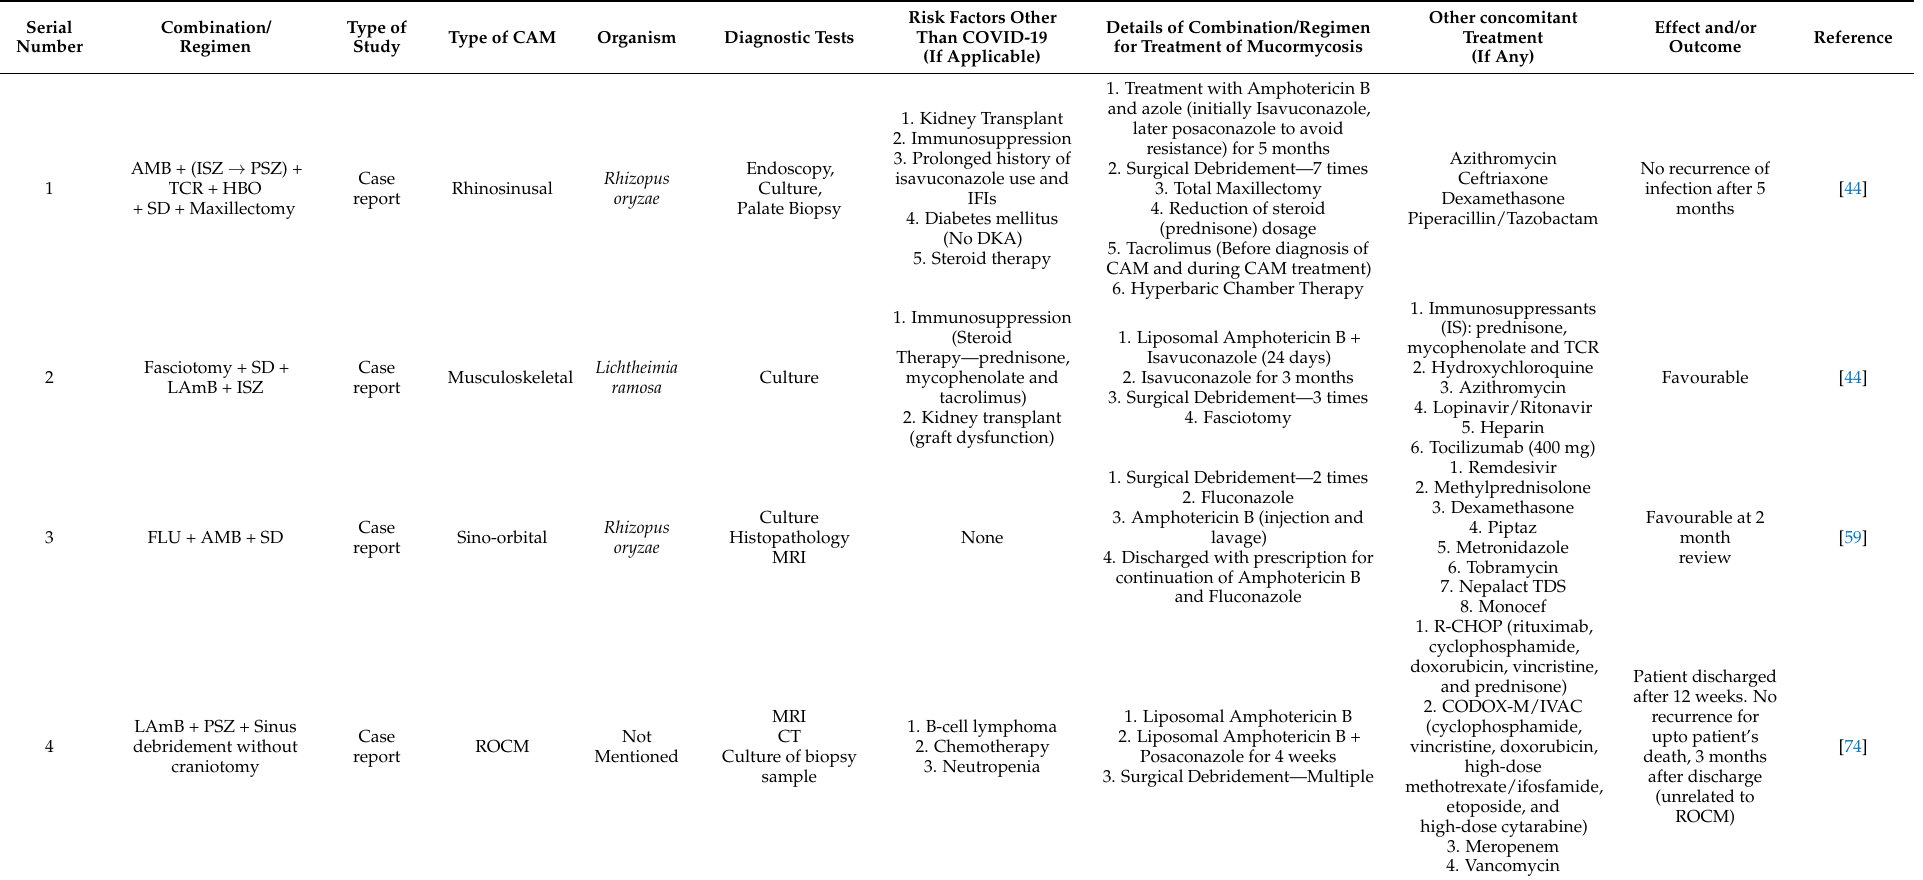
Table 2. Combinational drug therapy used in the treatment of